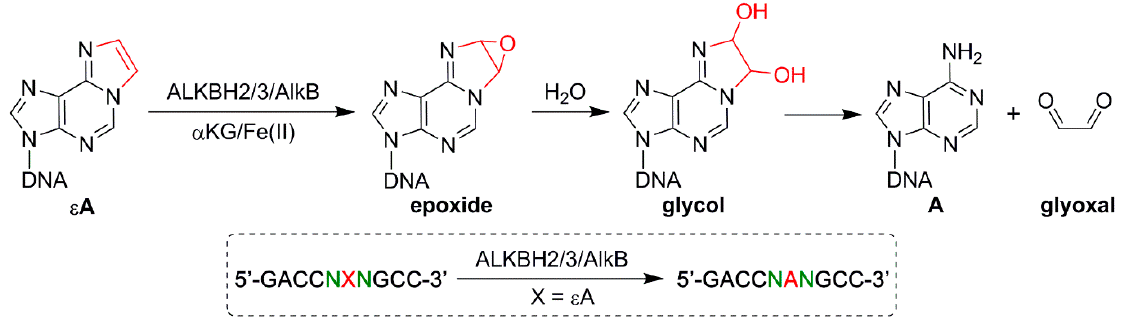
Figure 1. Mechanism of the AlkB family DNA repair enzymes dealkylating ε A and the design of the 16 sequence contexts for ε A repair. X represents the ε A adduct and N represents the G/A/T/C flanking base from the 5 ′ and 3 ′ ends.